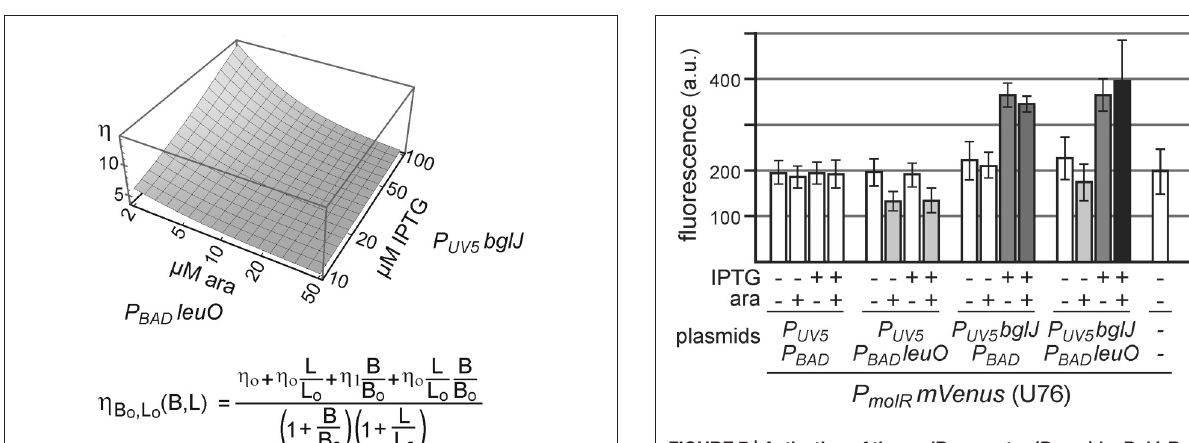
FIGURE 7 | Activation of the molR promoter ( P molR ) by BglJ-RcsB is not affected by LeuO. For determining activation of P molR by BglJ-RcsB strain U76 was used that carries a replacement of the molR coding region by mVenus . Transformants of U76 with plasmids carrying P UV 5 bglJ (pKETS26) and P tac leuO (pKES303) as well as control plasmids (pKETS24 and pBAD30) were grown in tryptone medium for 5h. For induction (+) IPTG (100 µ M) and arabinose (50 µ M) were added. When harvested, the cultures had an OD 600 of approximately 1, while induction of leuO resulted in slower growth to OD 600 of approximately 0.6. Yellow fluorescence of three biological replicates was determined and expression levels are given in arbitrary units (a. u.). leuO plasmid pKES303 and control plasmid P UV 5